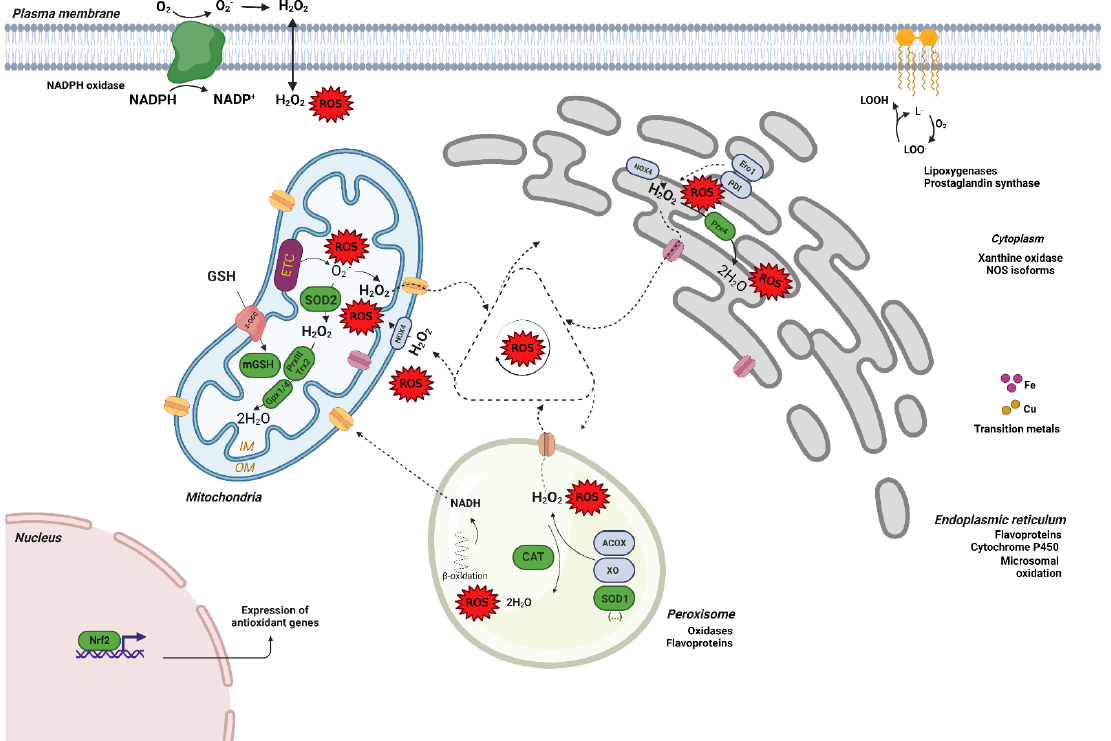
Figure 2. Major sources of ROS inside the cells. ROS is produced at different sites inside the cell such as mitochondria, endoplasmic reticulum, peroxisomes, plasma membrane or cytoplasm. Yet, ROS can be liberated through specialized channels or aquaporins and enter in neighboring organelles. To combat these highly reactive species the cell poses antioxidant mechanisms comprising enzymatic (SODs, CAT, Gpx, Trx, Prx) and non-enzymatic components (GSH, Nrf2 transcriptional activity). Interorganellar interactions are represented by dotted arrows. ACOX: Peroxisomal acyl-coenzyme A oxidase; CAT: catalase; Ero1: endoplasmic reticulum